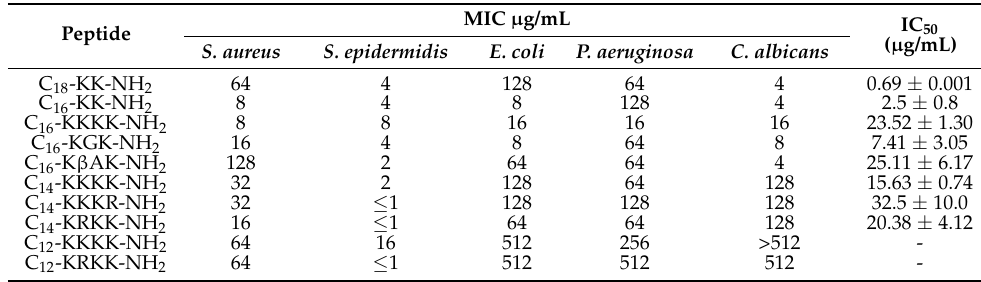
Table 1. Antimicrobial activity of lipopeptides against selected microorganisms and IC 50 values determined by the tests on human keratinocytes